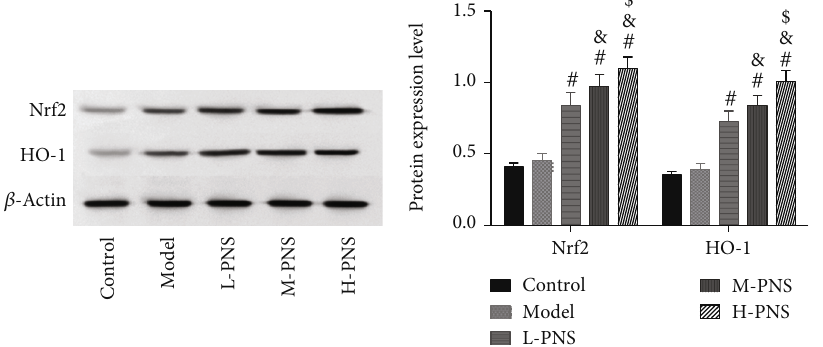
Figure 6: Nrf2 and HO-1 protein expression in kidney tissue ( ∗ P < 0 : 05 vs. control; # P < 0 : 05 vs. model; & P < 0 : 05 vs L-PNS; $ P < 0 : 05 vs. M-PNS).